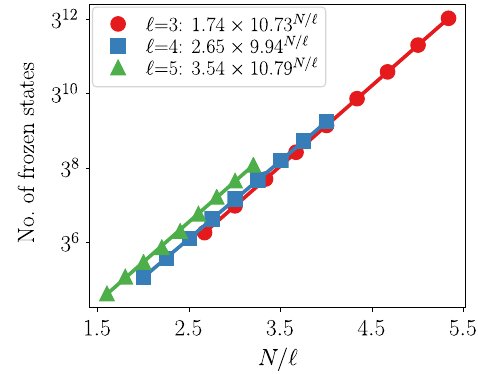
FIG. 7. Scaling of the number of frozen states for Hamiltonians with at most range l terms. We consider Hamiltonians with all possible combinations of charge- and dipole-conserving terms, quartic in spin operators of a range at most l , for l ¼ 3 , 4, 5. The number of frozen states grows exponentially with system size N , with an exponent that decreases with l , but is larger than the analytical lower bound 2 × 5 N=l